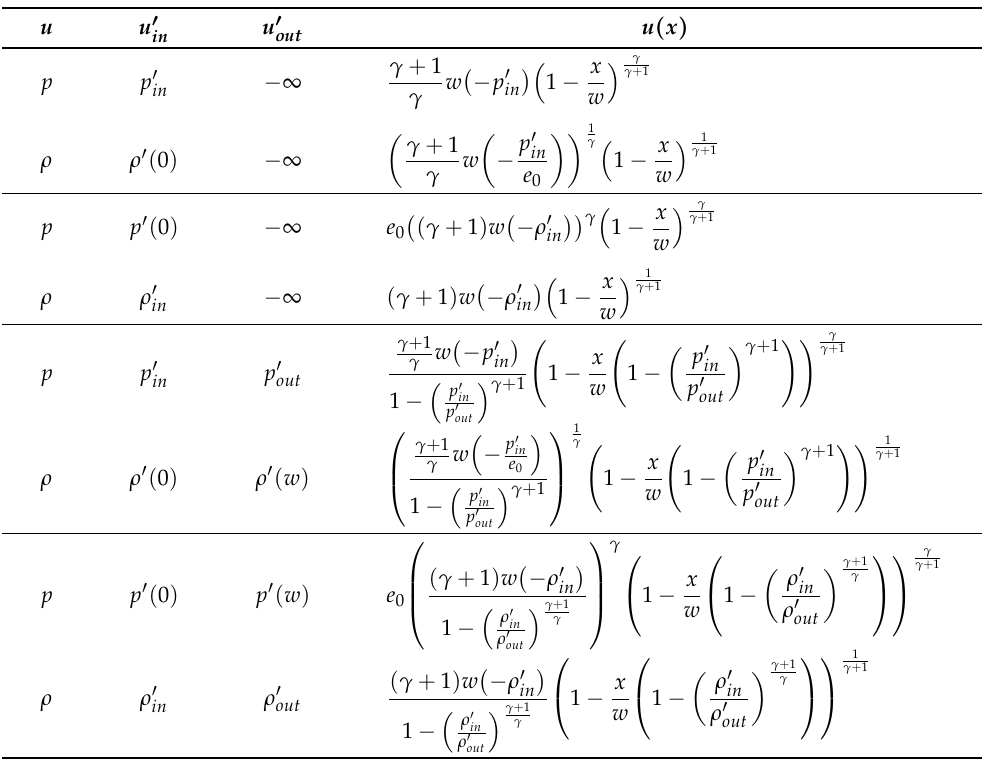
Table 4. Overview of stationary solutions to Neumann